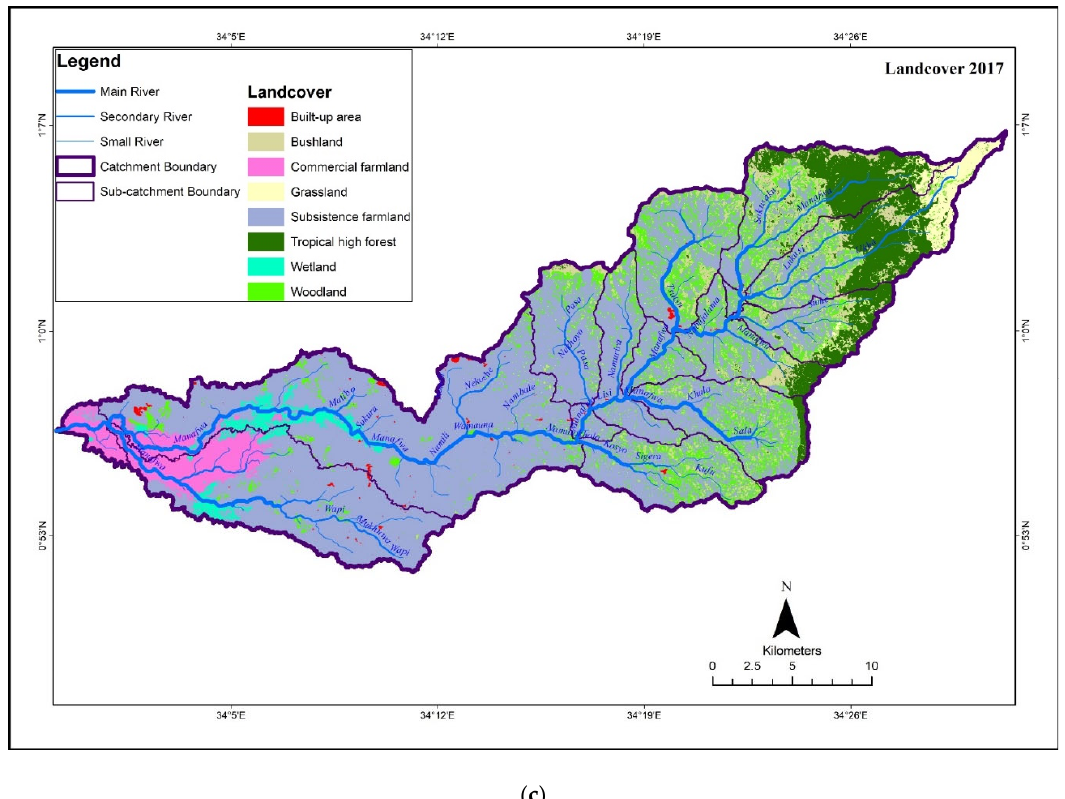
Figure 2. ( a ) Land use land cover Map of 1995. ( b ) Land use land cover Map of 2008. ( c ) Land use land cover Map of 2017.